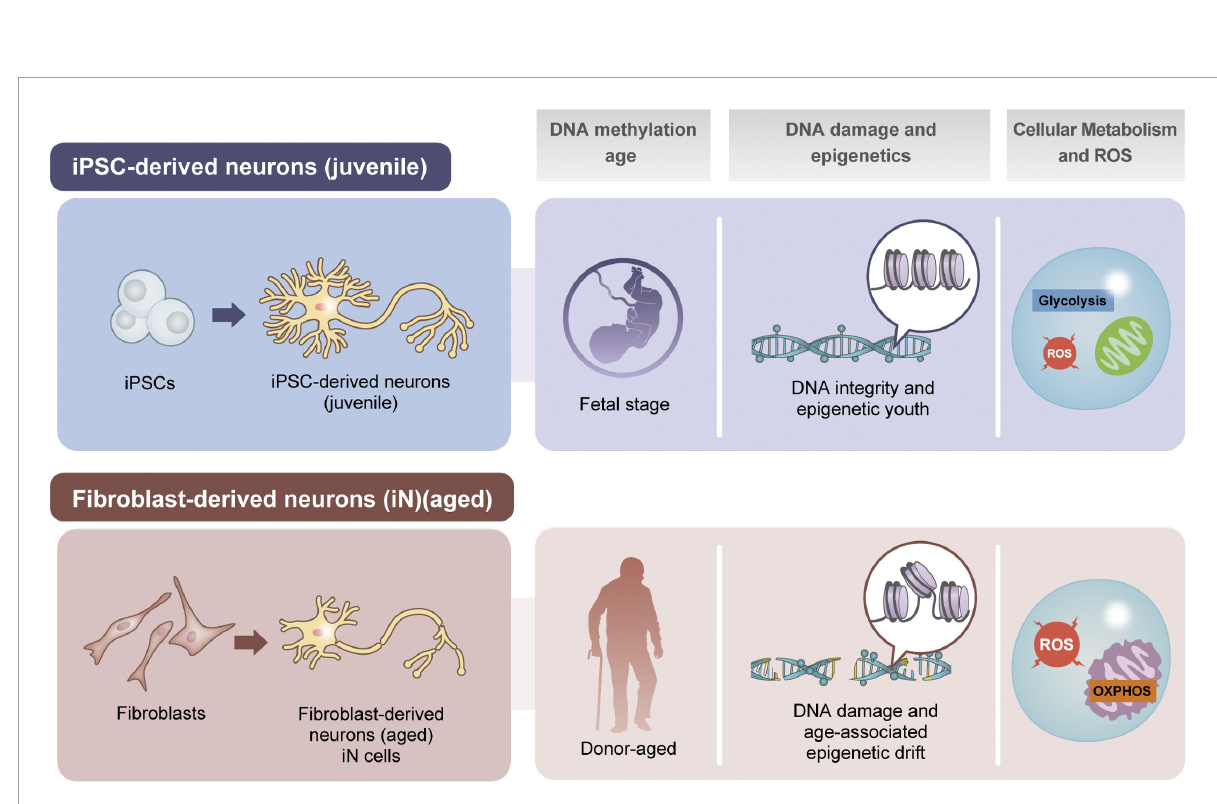
FIGURE2 Comparison of iPSC- or fibroblast-based approaches for disease recapitulation. In many aspects such as genomic DNA methylation, damage and epigenetic factors, and cellular metabolic status are different in neurons depending on the resources of